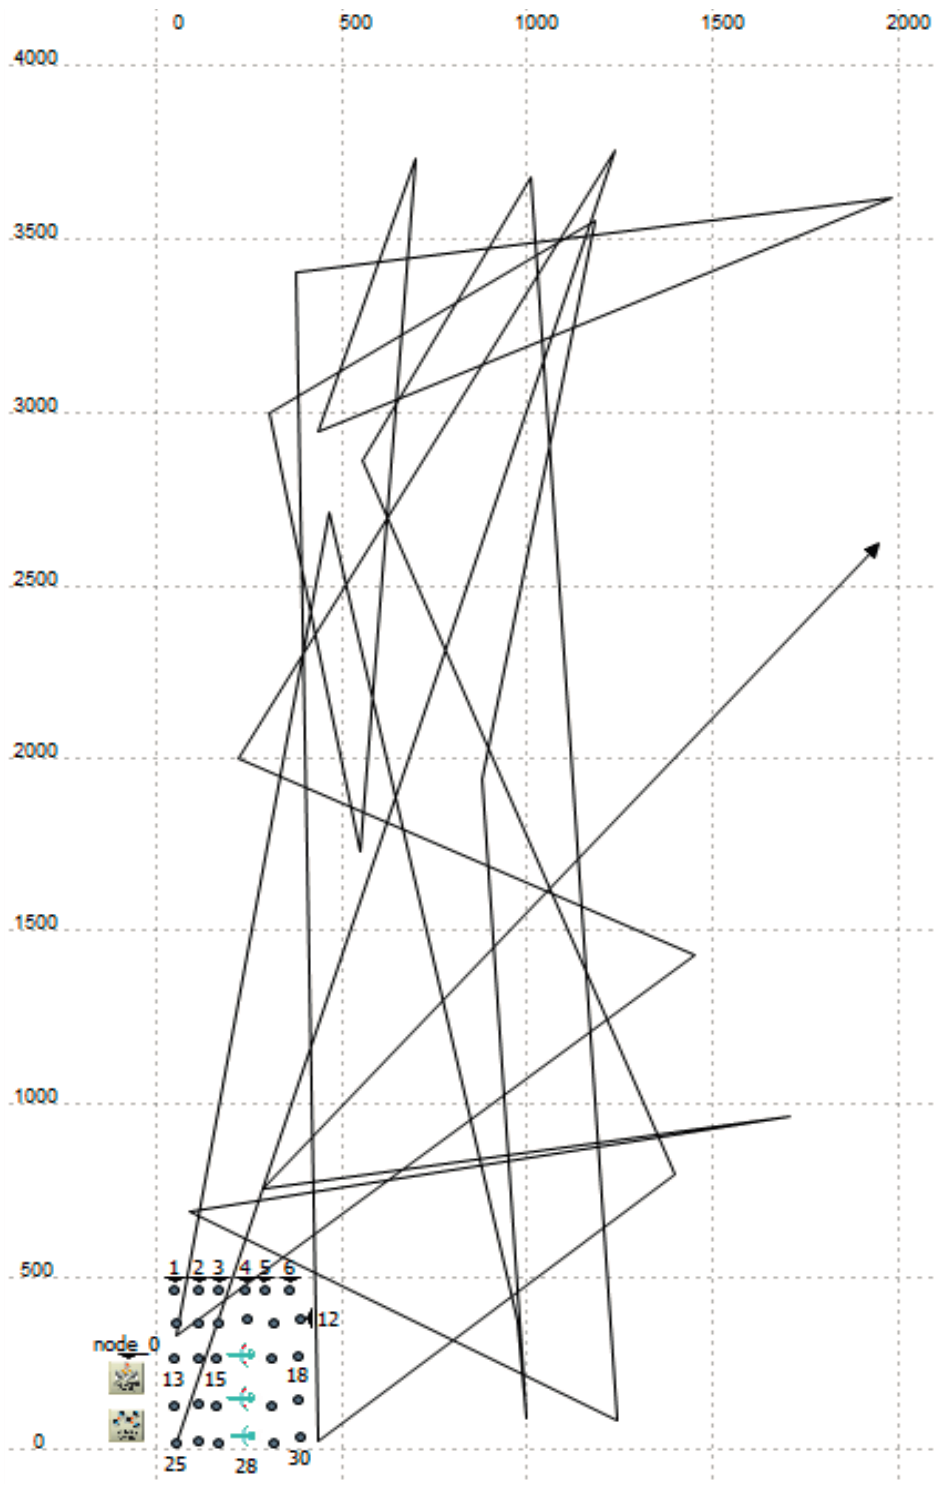
Figure 1. Trajectory of a UAV under the random waypoint (RWP)